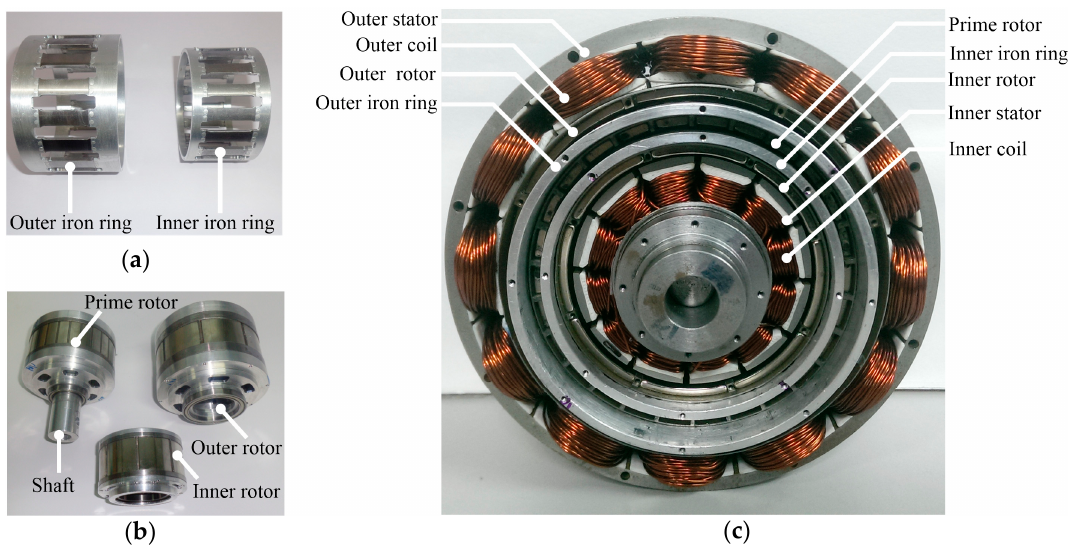
Figure 9. The fabricated components and assembled prototype generator: ( a ) Iron rings; ( b ) PM rotors; ( c ) Assembled prototype.